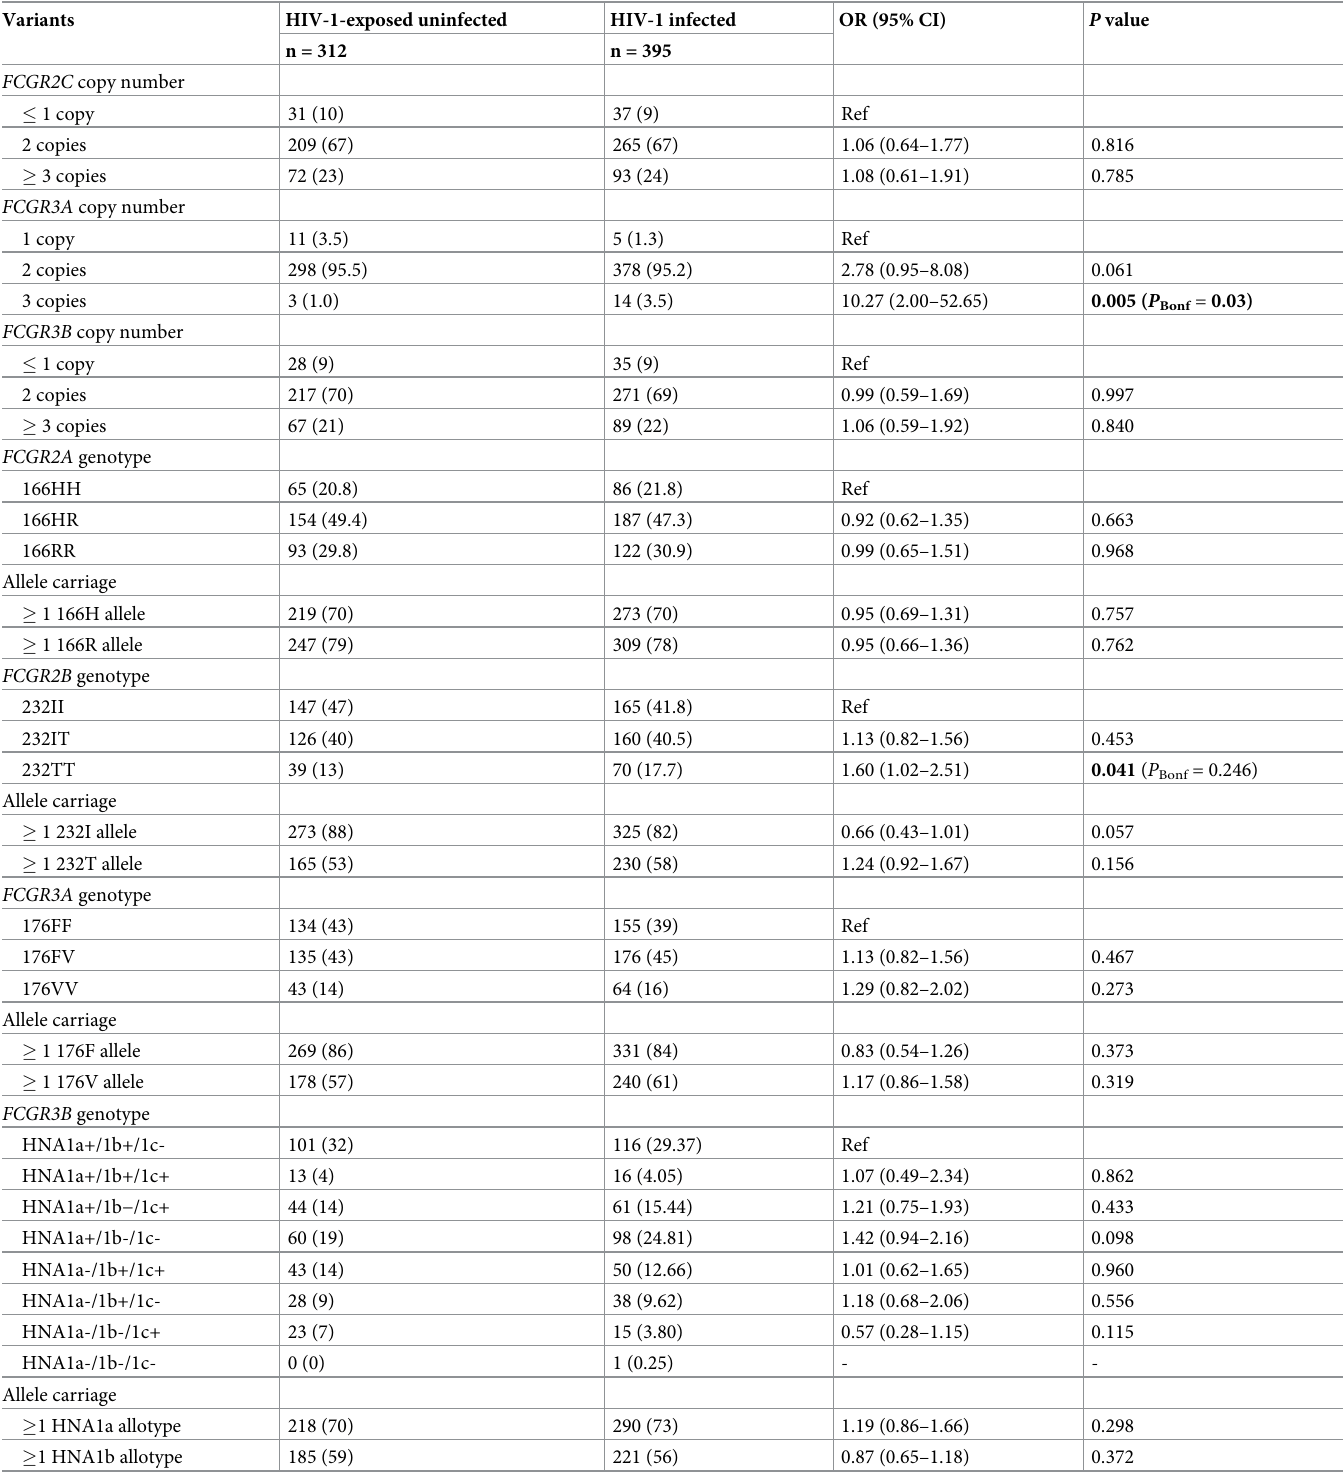
Table 2. Associations of FCGR variants with perinatal HIV-1